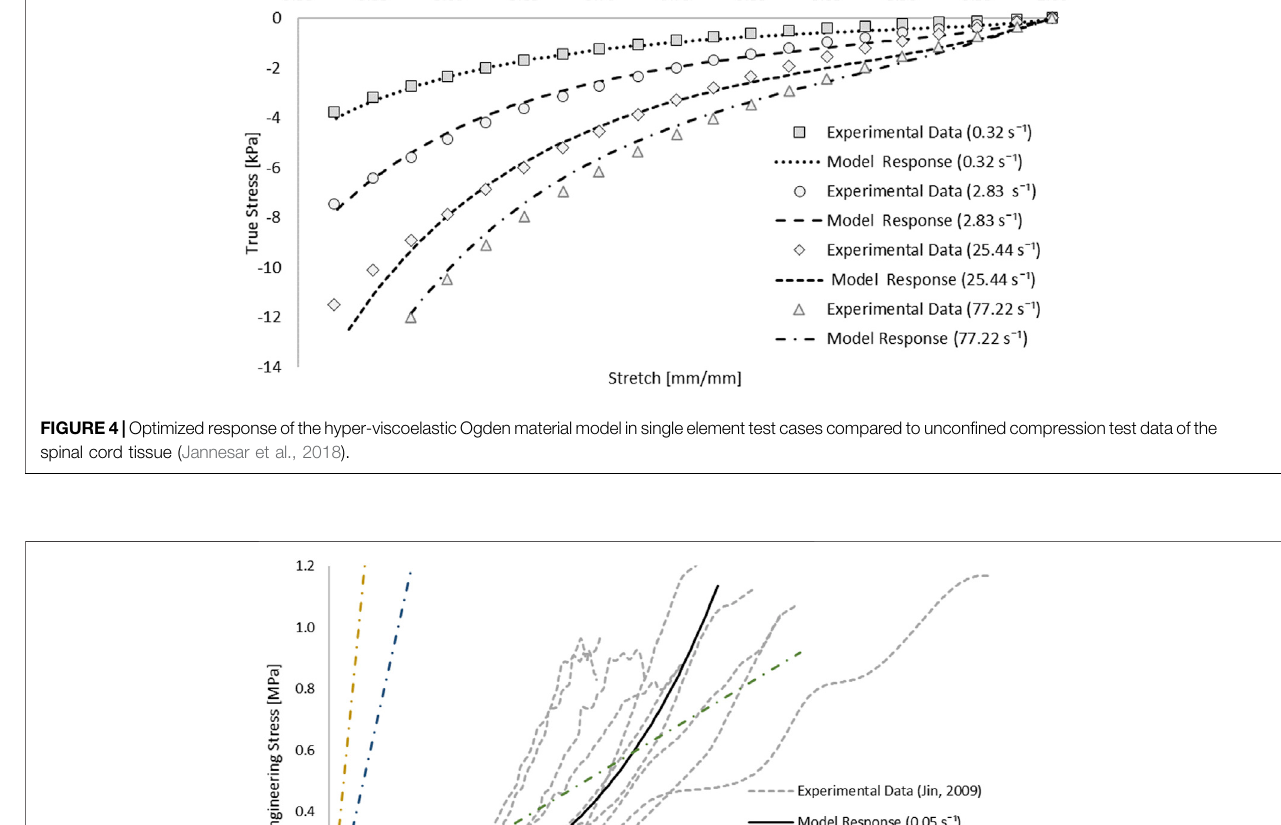
experimental curves: 0.32, 2.83, 25.44, and 77.22 s − 1. Single